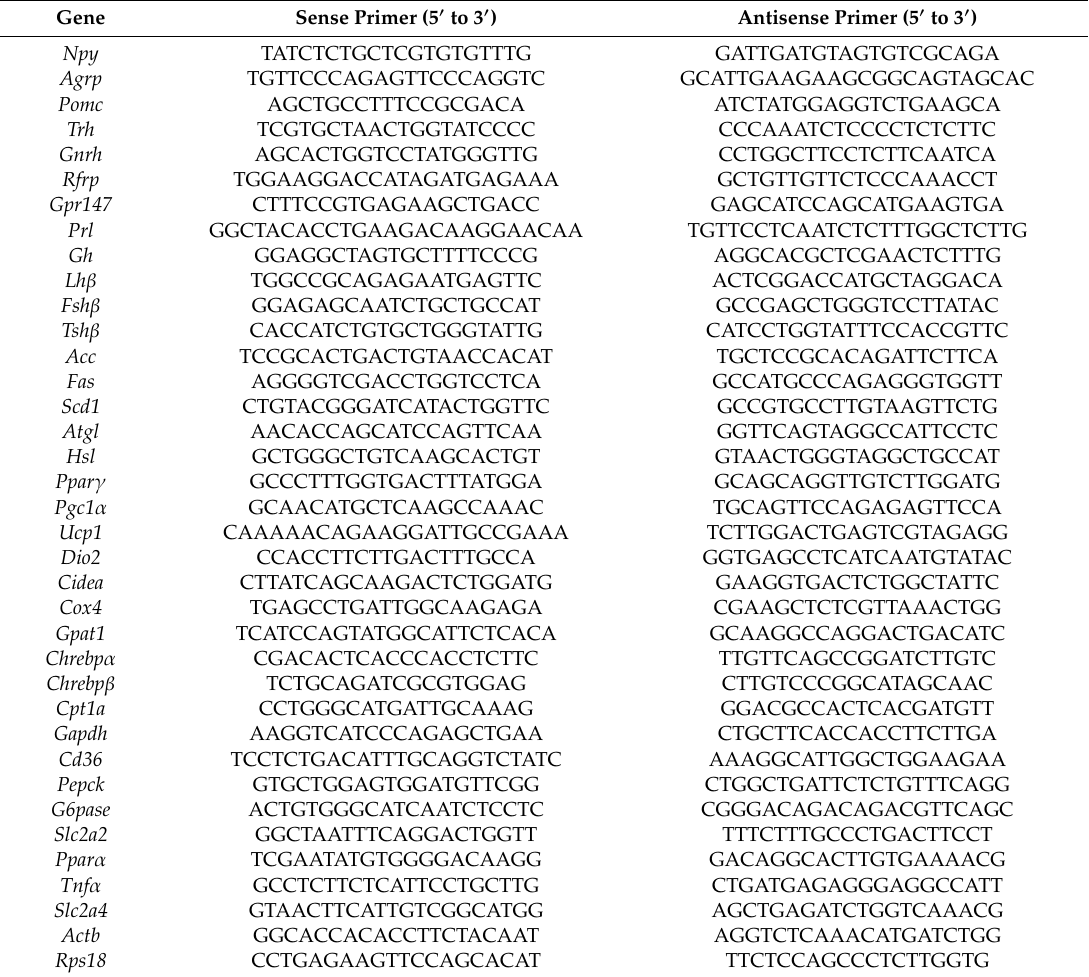
Table 2. Sequences of oligonucleotide primers for